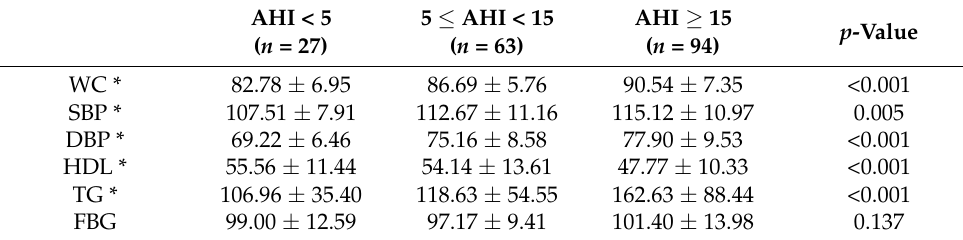
Table 2. Parameters of metabolic syndrome according to OSA groups.